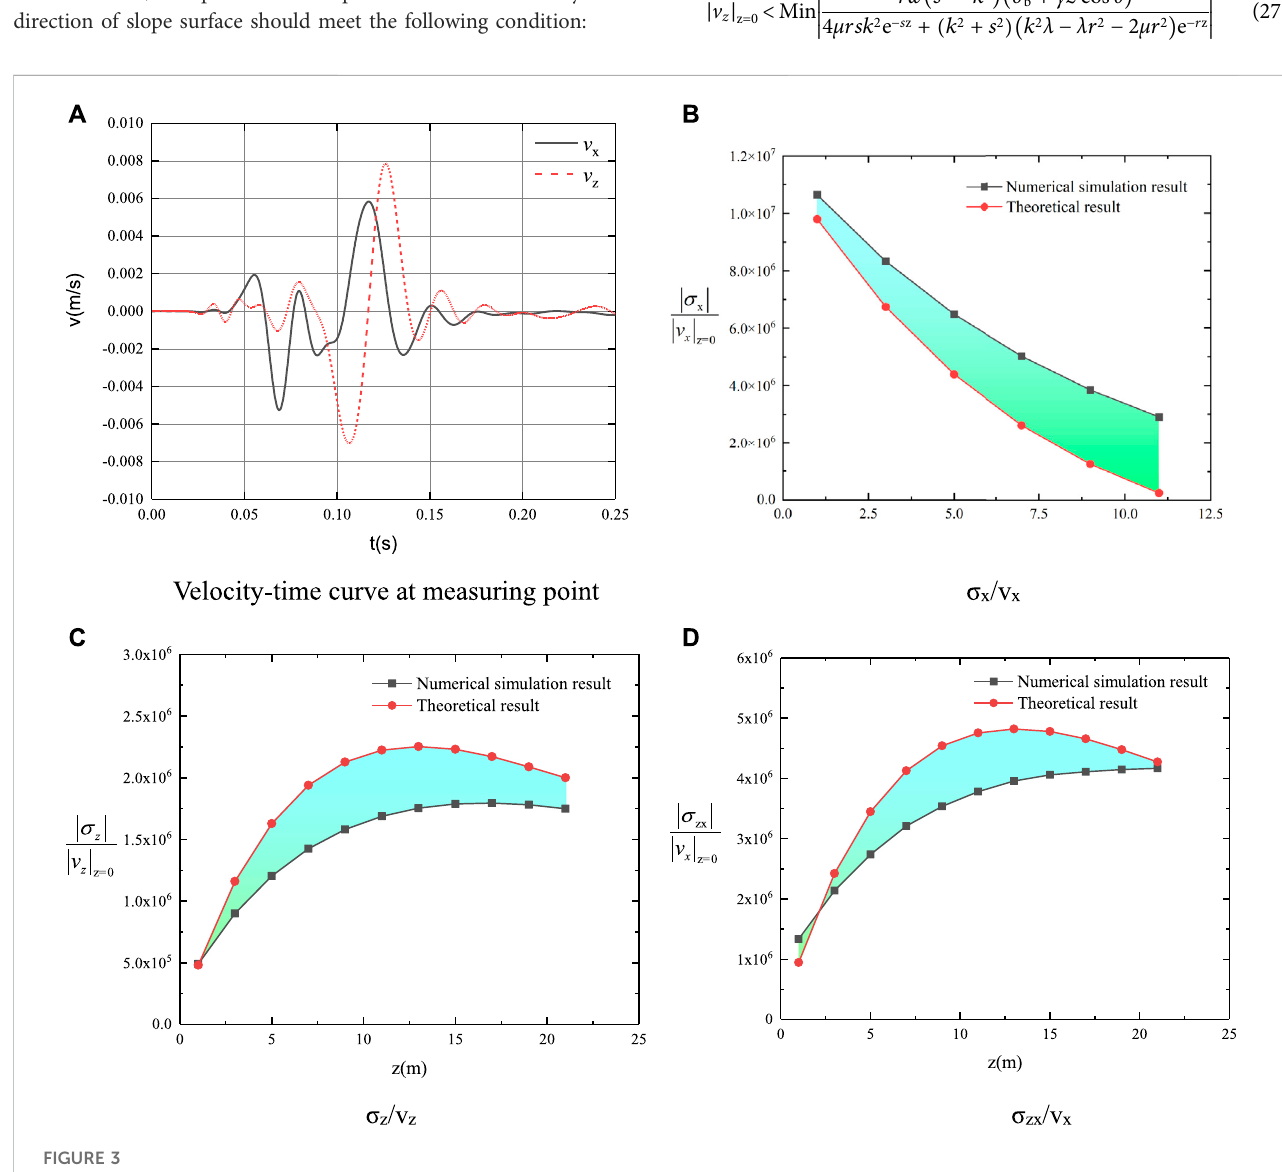
Frontiers in Earth